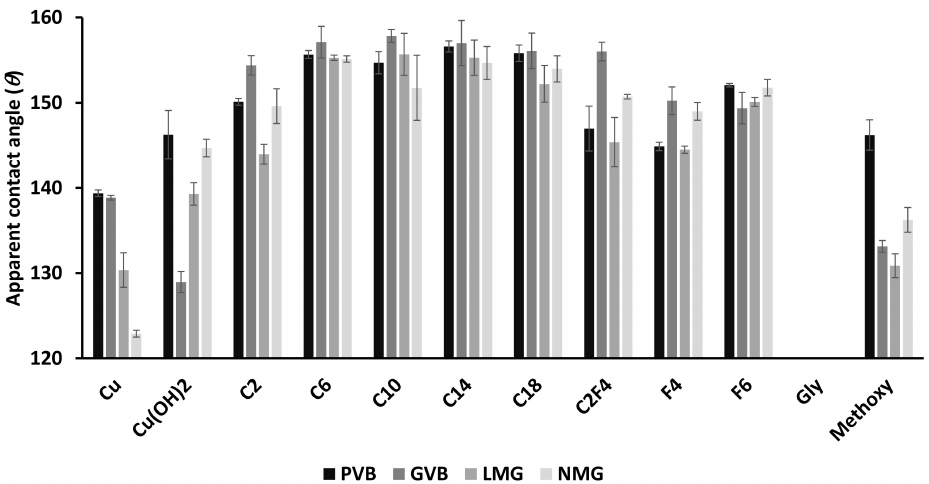
Figure 9. Wettability measurements for printed surfaces for all raw or functionalized surfaces (From dark to clear: PVB, GVB, LMG and